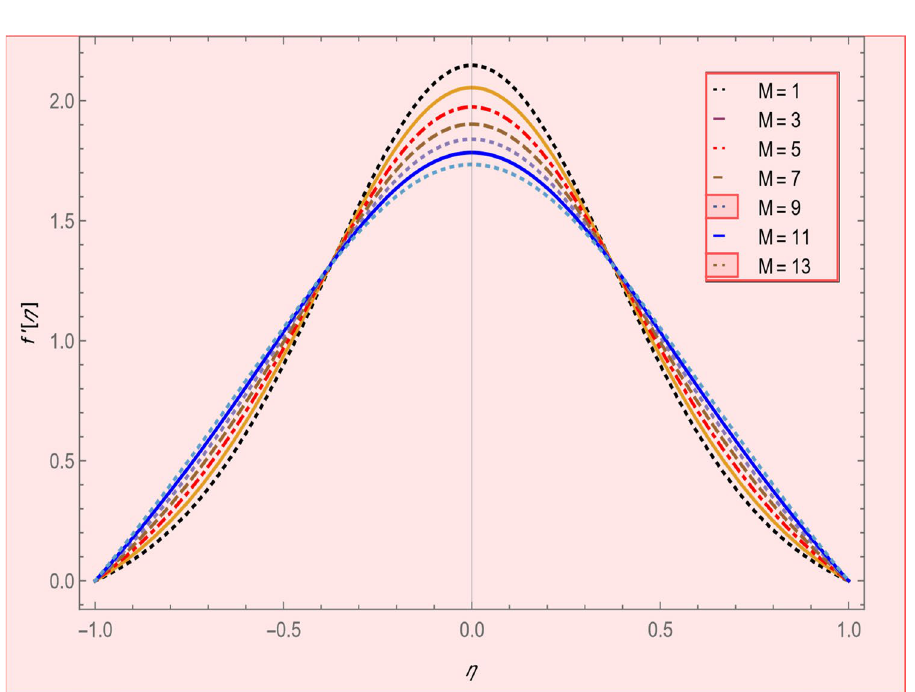
Figure 9. Radial velocity effect in magnetic parameter profile for α = 4, R = − 1, ϕ 1 = ϕ 2 = 0.04, SC = 1, Pr = 6.2